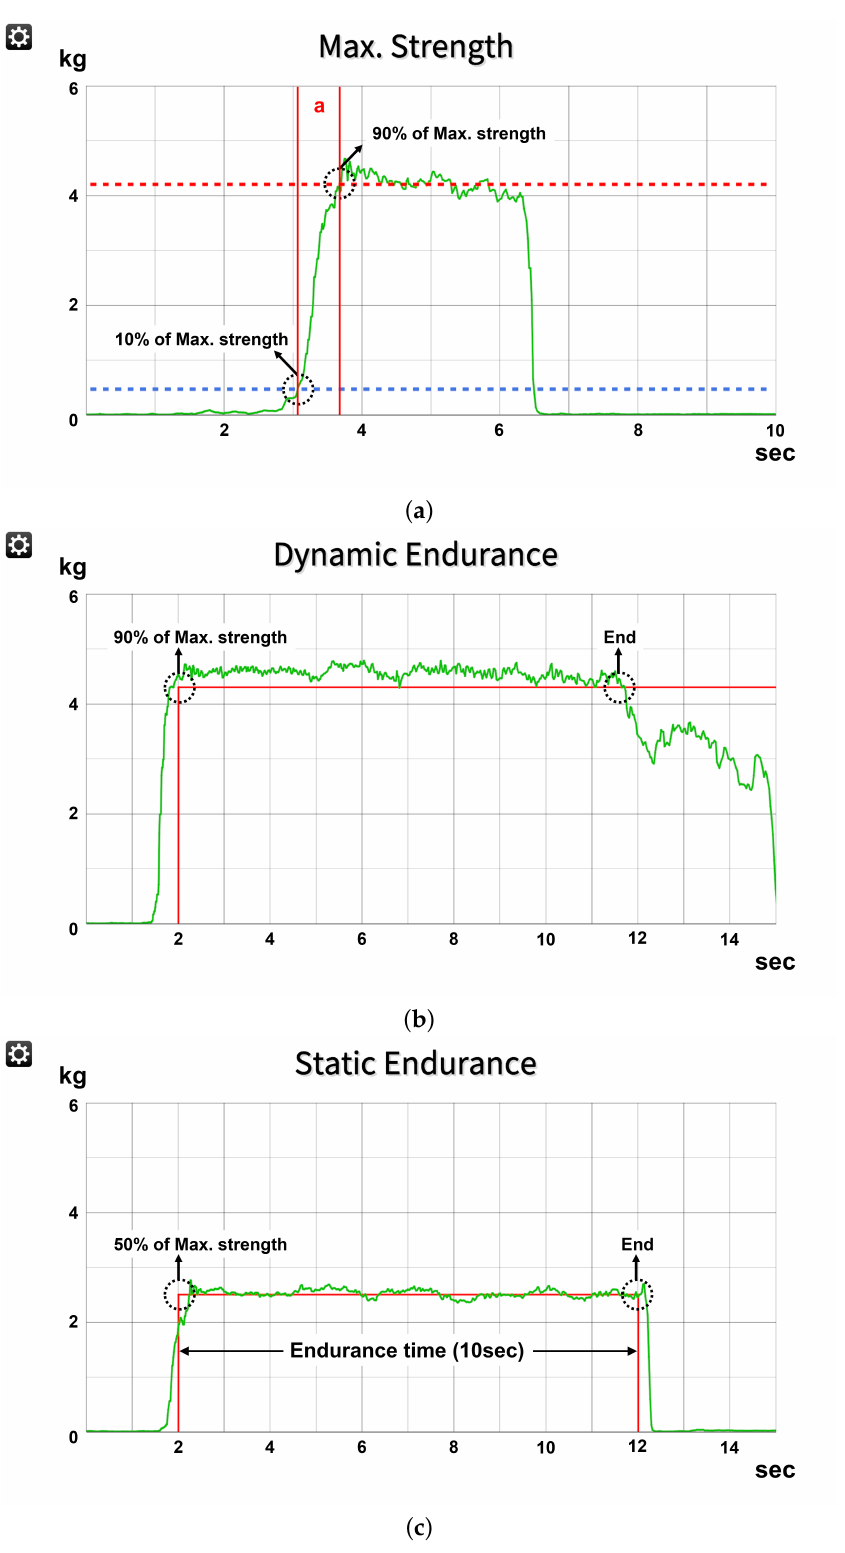
Figure 5. Software to analyze hand function endurance using the tapping strength and duration of operation. ( a ) Maximum tapping strength; ( b ) Dynamic endurance; ( c ) Static